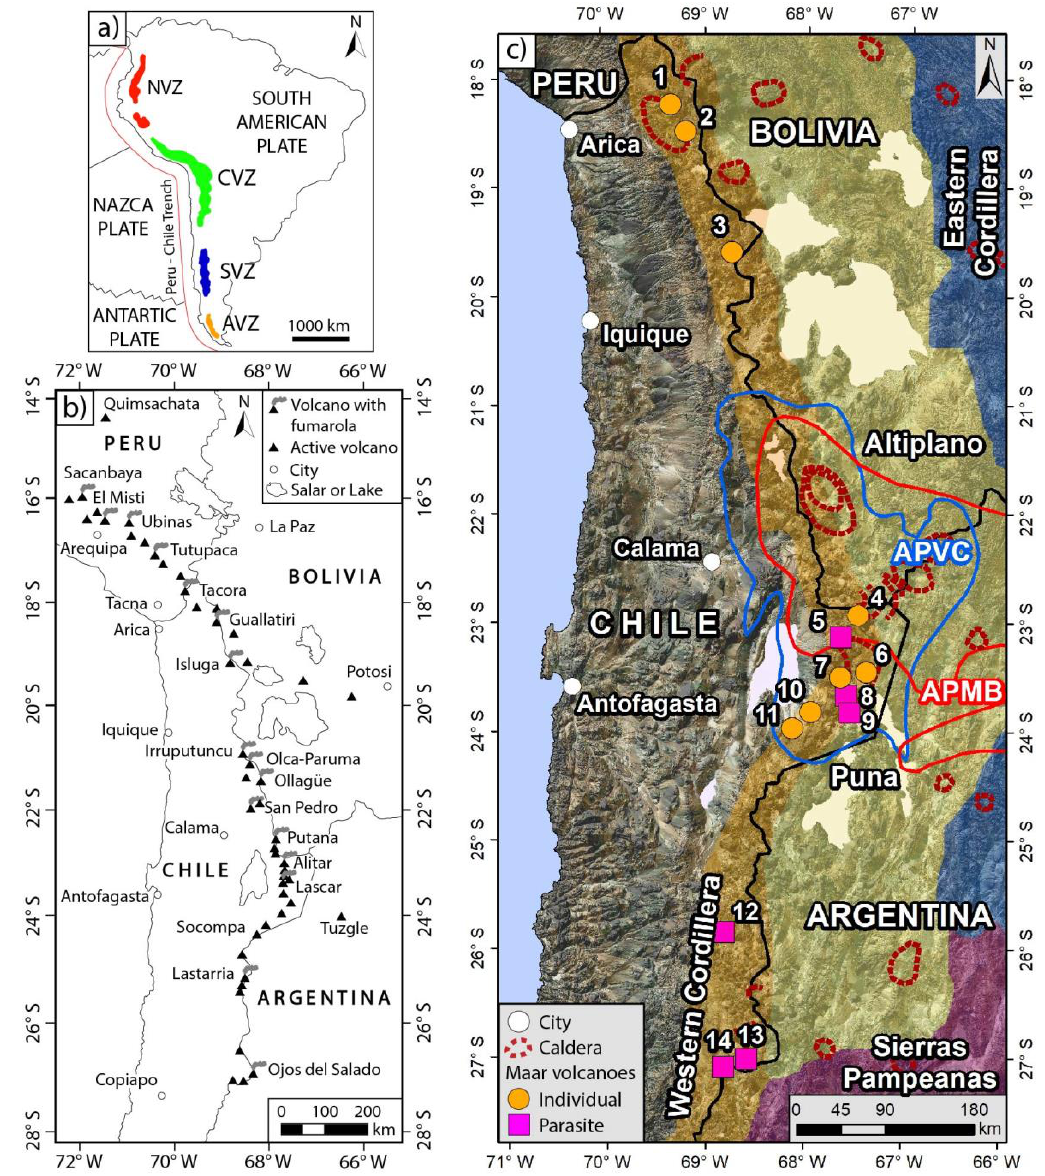
Figure 1. Location maps. ( a ) Map showing the location of the Northern, Southern, Central, and Austral Volcanic Zones (NVZ, CVZ, SVZ, and AVZ, respectively) of the Andes defined by Thorpe and Francis [55] (Modified from [36]). ( b ) Location map of the CVZ (Modified from [36]) showing the main active polygenetic volcanoes [56]. ( c ) Map of northern Chile showing the location of the maar volcanoes in northern Chile and major morpho-volcano-tectonic units of the Central Andes (Modified from [57–59]). (APVC) Altiplano-Puna Volcanic Complex; (APMB) Altiplano-Puna Magma Body; (1) Michacollo; (2) Lliza; (3) Churullo; (4) Jorullo or Pampa Redonda; (5) Alitar; (6) Corral de Coquena; (7) Cerro Overo; (8) Puntas Negras; (9) El Laco Sur; (10) Cerro Tujle; (11) Tiloc á lar Sur; (12) Juan de la Vega; (13) Baker; (14) La